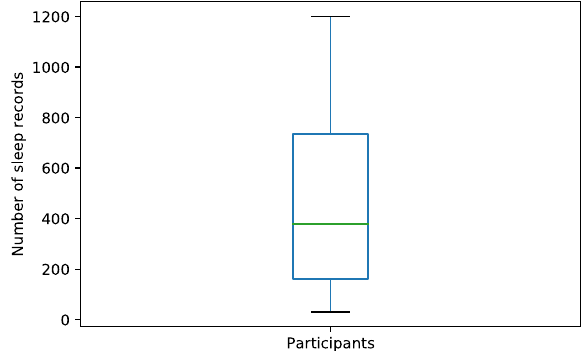
Fig. 5 Boxplot of total sleep records contributed by participants. Boxplot statistics are as follows (Min = 31, Q1 = 161, Median = 379, Q3 = 736, Max =